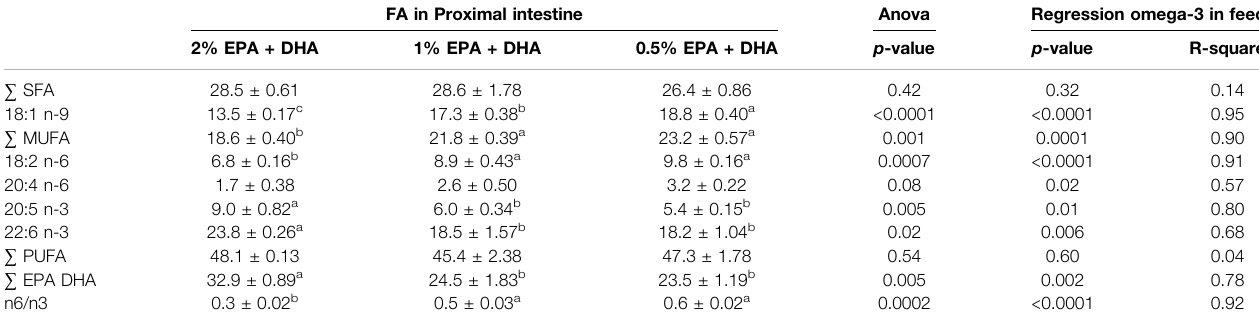
TABLE 5 | Fatty acid (FA) composition (% of total) in phospholipid (PL) fraction of Atlantic salmon proximal intestine second sampling (68 days after transfer to